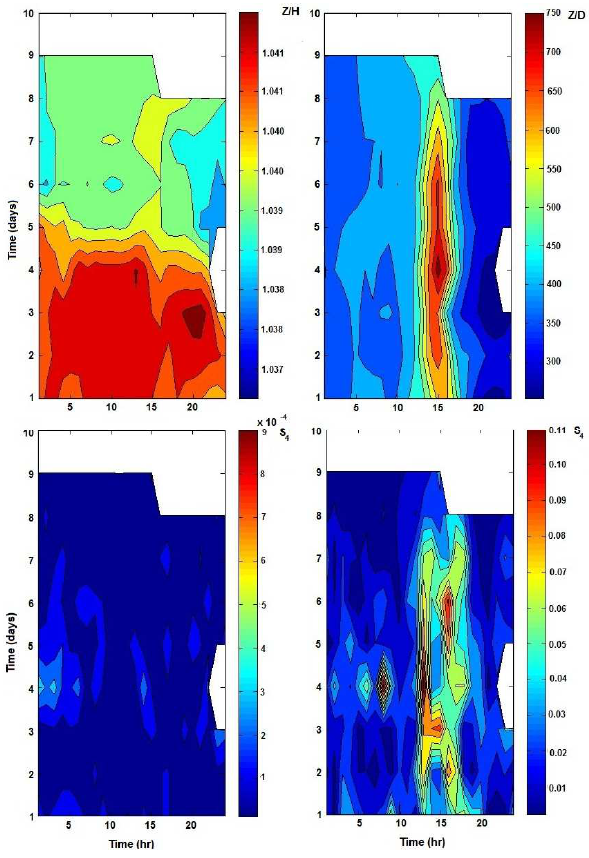
Fig. 4. Map showing the time series of the analysis for the first Figure 4. Map showing the time series of: The analysis for the first second event Z/H and Z/D 2 second event Z/H and Z/D top right and left, respectively. At the top right and left, respectively. At the bottom, the variation index for Z/H (left), and for Z/D 3 bottom, the variation index for Z/H (left), and for Z/D (right). There are no data in the white (right). There is no data in the white areas. 4